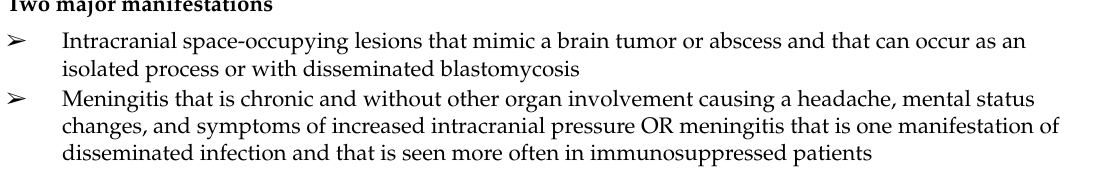
Table 1. Salient Points Regarding Central Nervous System (CNS)